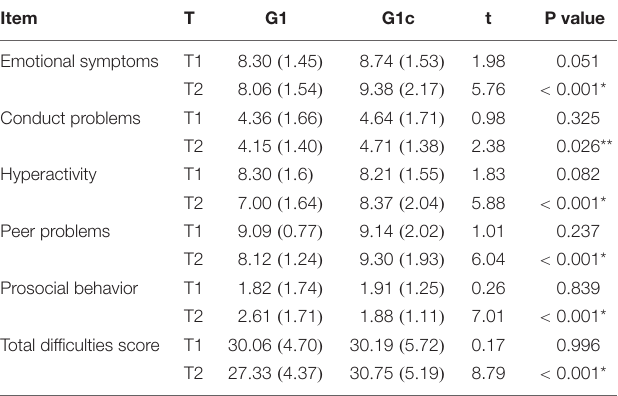
TABLE 7 | Comparison of T1 and T2 SDQ scores between G1 and